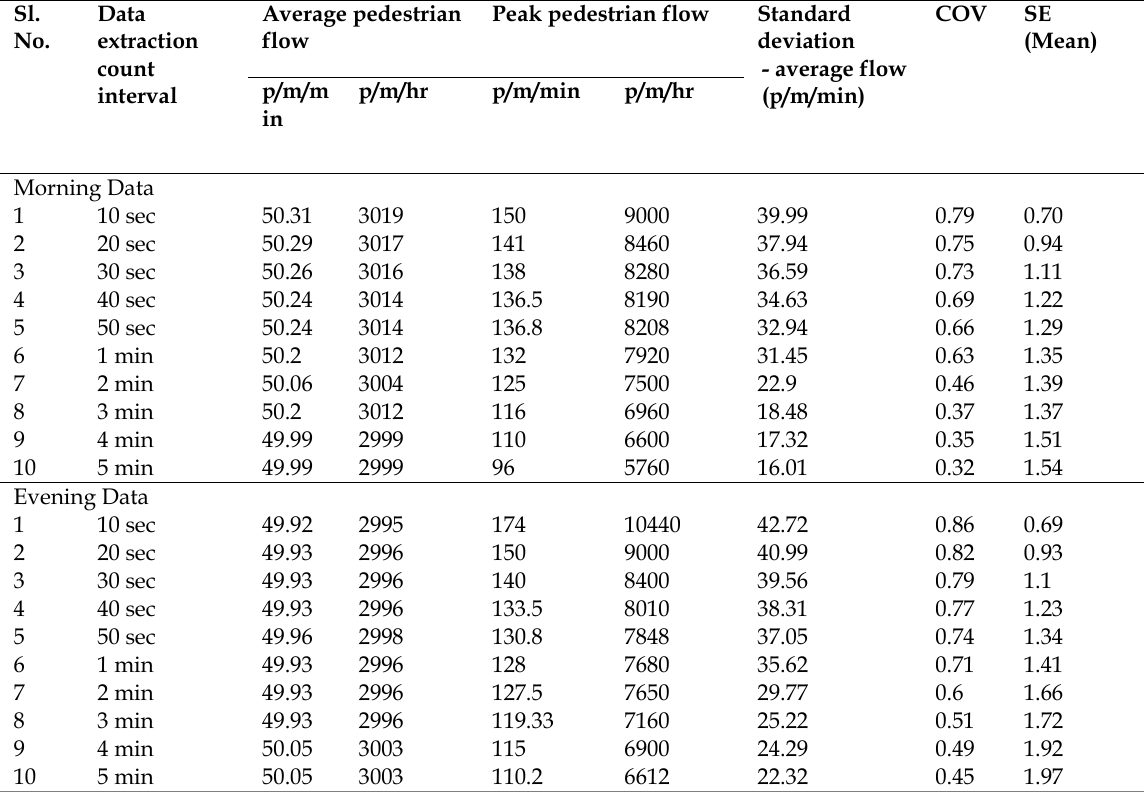
Table 4. Pedestrian Flows with respect to Data Extraction Count Periods